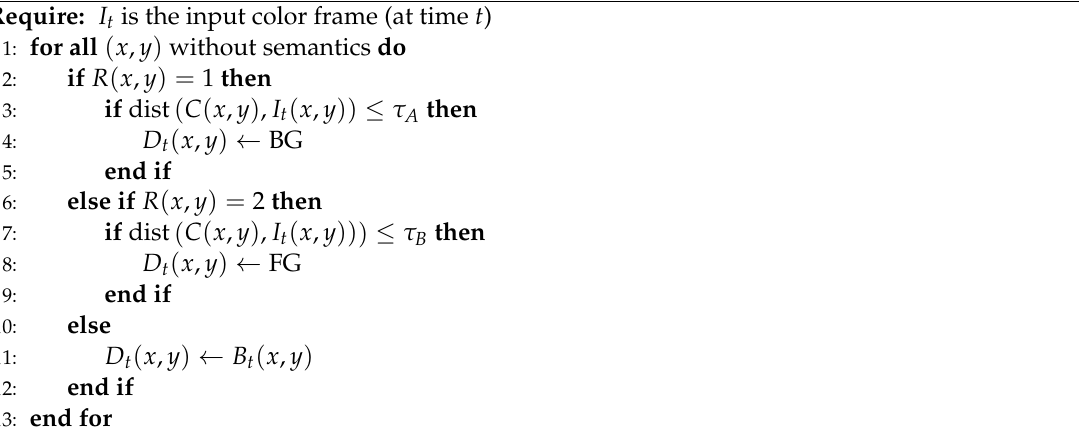
Algorithm 2 Pseudo-code of ASBS for pixels without semantics, rule A , rule B or the fallback are